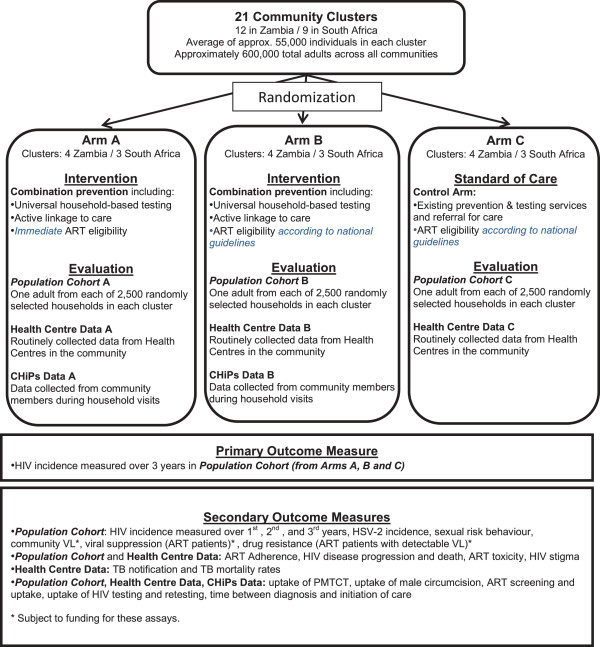
Summary of trial design.